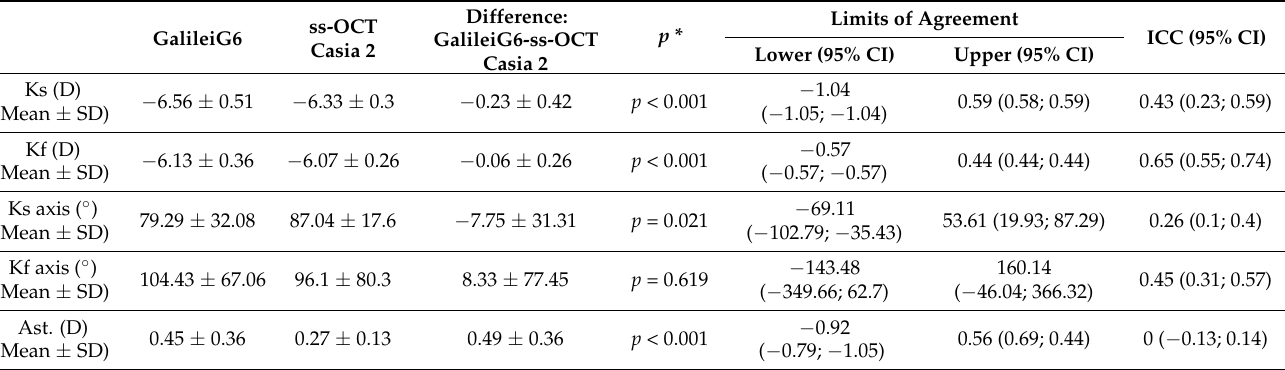
Table 2. Table comparing posterior Ks(D) and Kf (D), Ks axis( ◦ ), Kf axis( ◦ ), posterior astigmatism As.(D) measured with OCT Casia 2 and GalileiG6 Dual Scheimpflug Analyzer. ICC (introclass correlation coefficient) refers to the correlation between